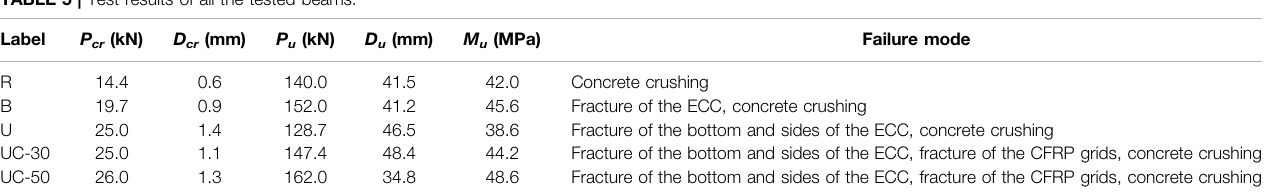
TABLE 5 | Test results of all the tested